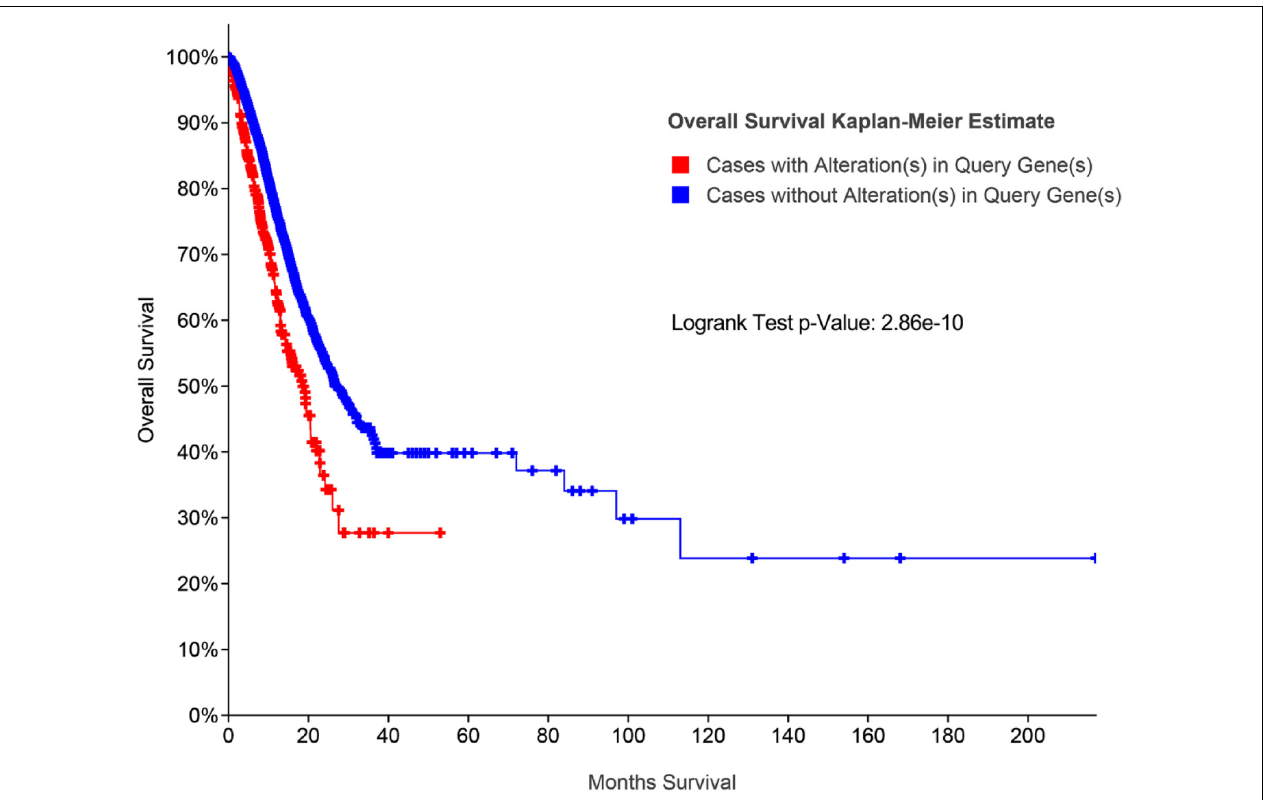
FIGURE 9 | Survival analysis for MYC by cBioPortal